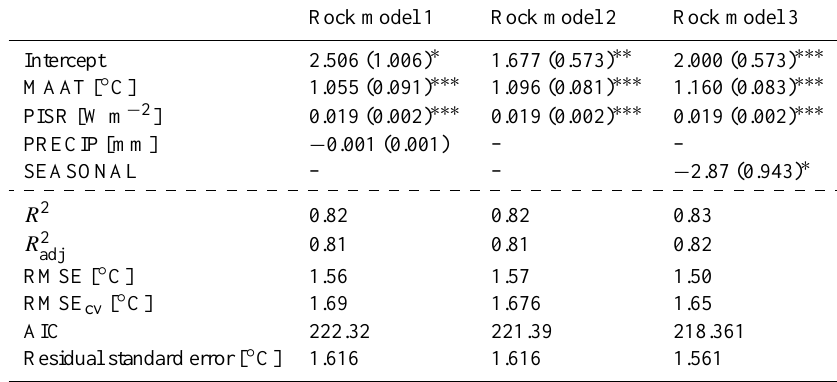
Table 5. Model coefficients (and standard errors in parentheses) of rock models using different sets of explanatory variables, and the corresponding goodness-of-fit statistics. Rock model 2 was chosen as final model. (The units for the explanatory variables are given in square brackets for each coefficient.)